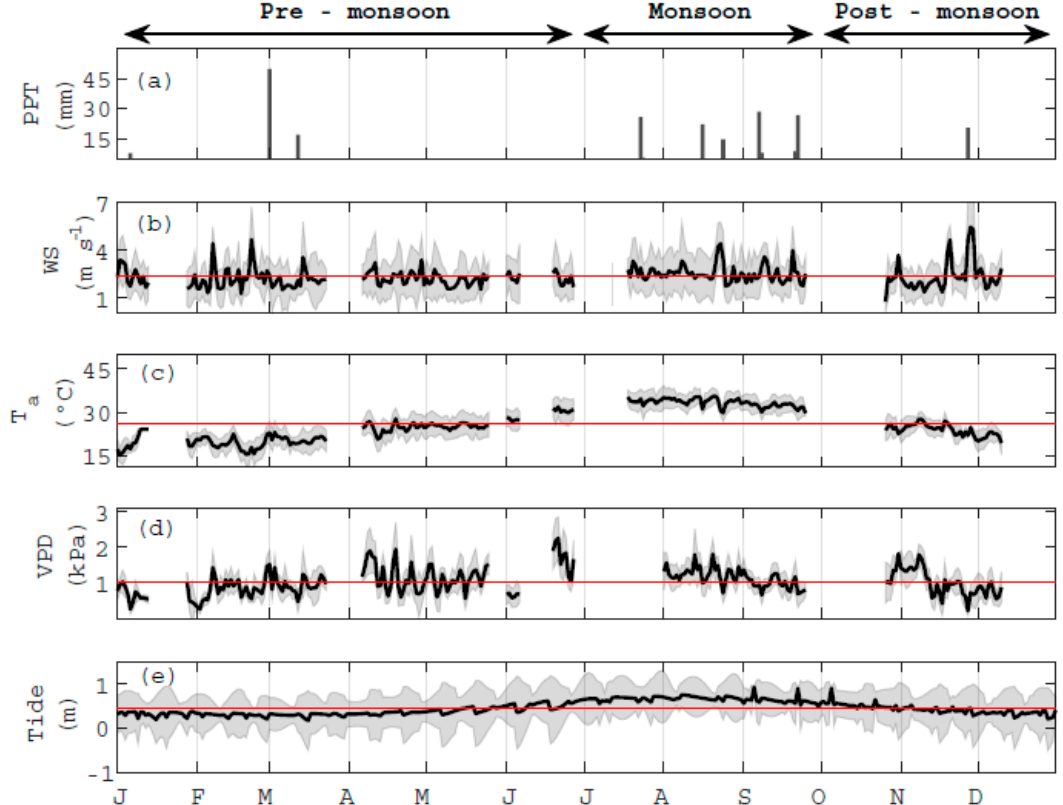
Figure 3. Daily times series of ( a ) daily accumulated precipitation (PPT), in subsequent panels, daily average (black lines), standard deviation (grey shaded area), and annual mean (red line) of ( b ) wind speed (WS), ( c ) air temperature (T a ), ( d ) vapor pressure deficit (VPD), and ( e ) tide height. Initial in x-axis from left to right J (January), F (February), M (March), A (April), M (May), J (June), J (July), A (August), S (September), O (October), N (November), and D ( December).Data gaps originated from instrument failure, maintenance, or quality assurance and quality control (QA/QC).